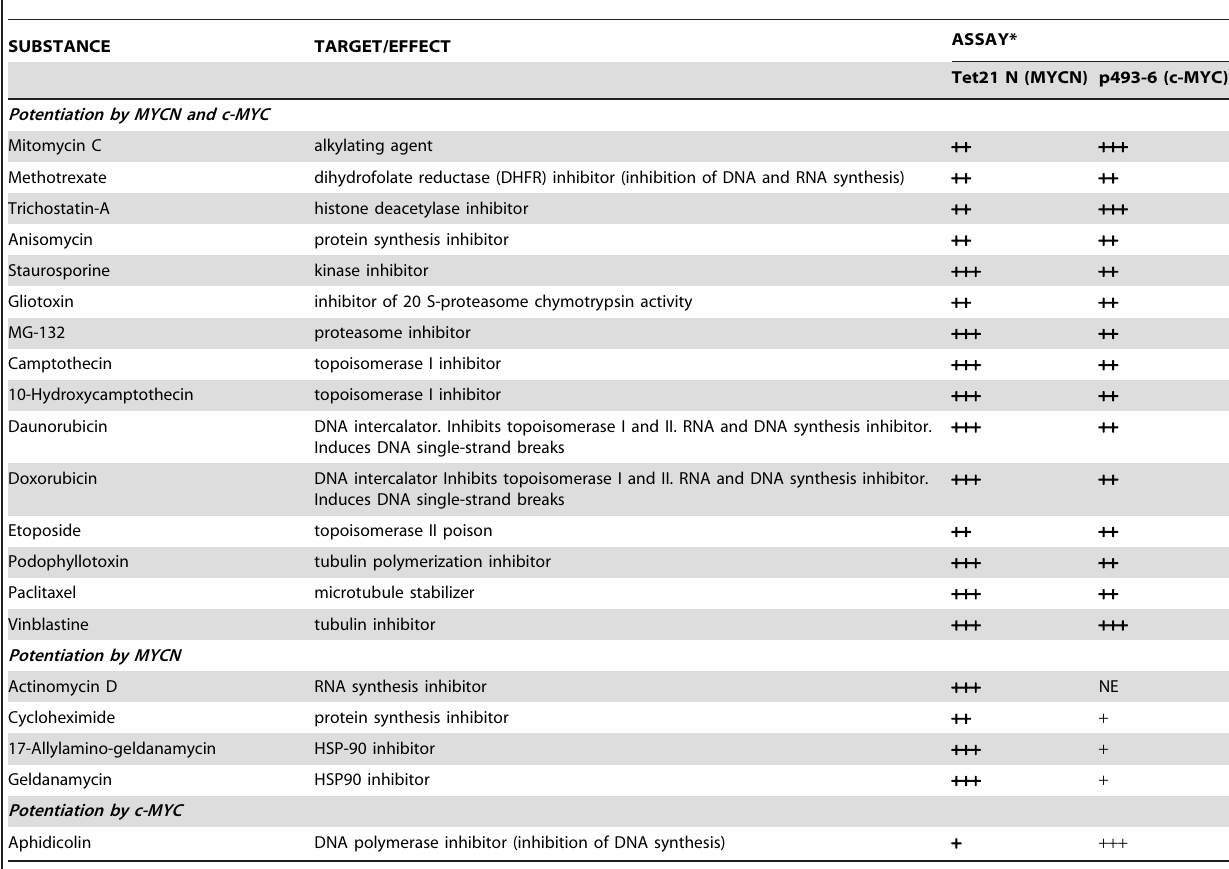
Table 1. Drugs that selectively targets MYC overexpressing